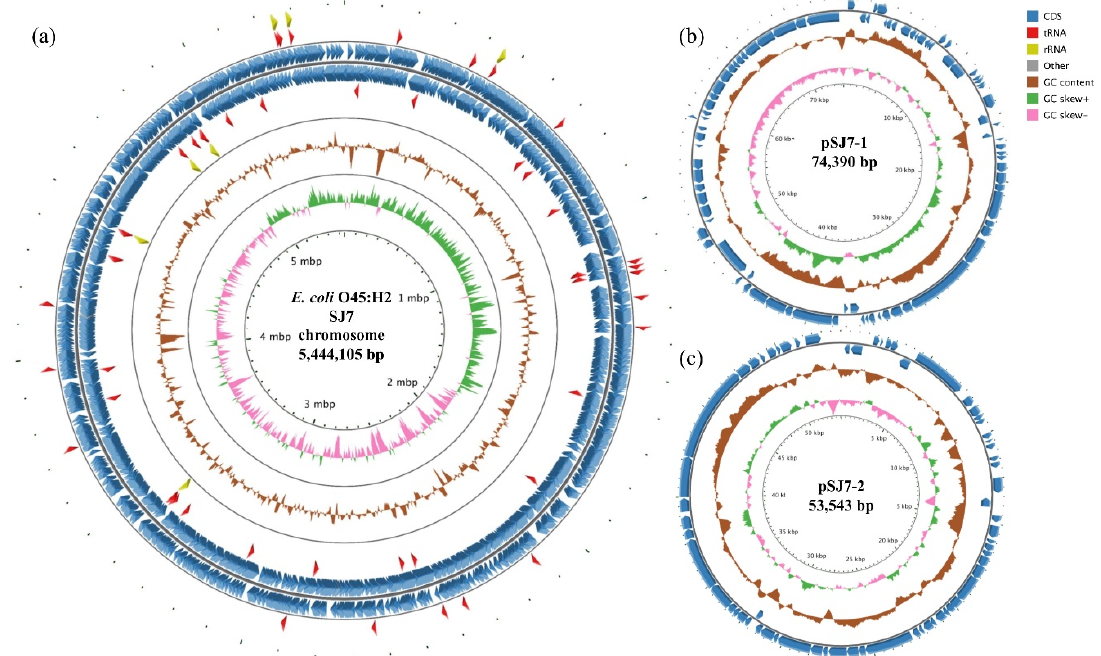
Figure 1. Circular genome maps of the chromosome ( a ), plasmid pSJ7-1 ( b ), and plasmid pSJ7-2 ( c ) for the clinical STEC O45:H2 strain SJ7 generated using CGview server. For the map of chromosome (a), the rings from the inside out represent the GC skew (green and pink), GC content (brown), coding DNA sequences (CDSs) (blue), tRNA (red), and rRNA (yellow). For the maps of two plasmids (pSJ7-1 and pSJ7-2), the same color codes are used, and no tRNA and rRNA were detected. The annotated functions of the CDSs are not indicated.